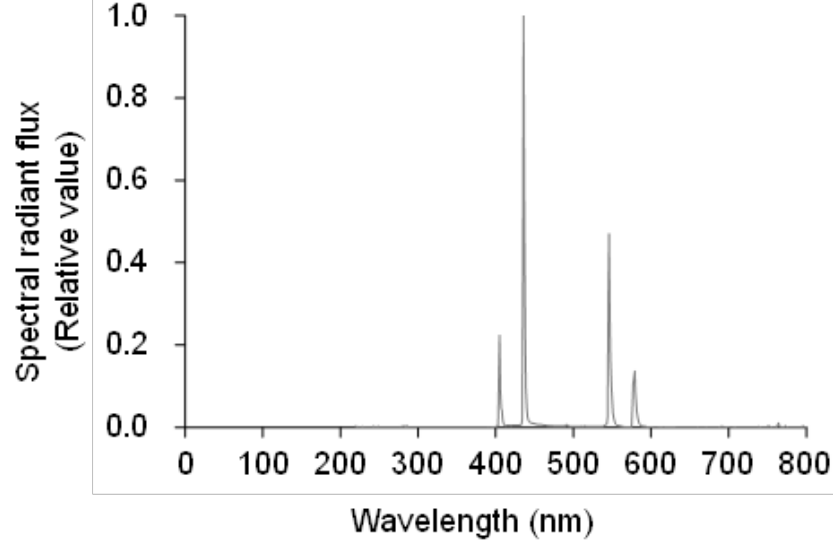
Figure 12. Spectral radiant flux from the UV-B lamp covered with the UV cut